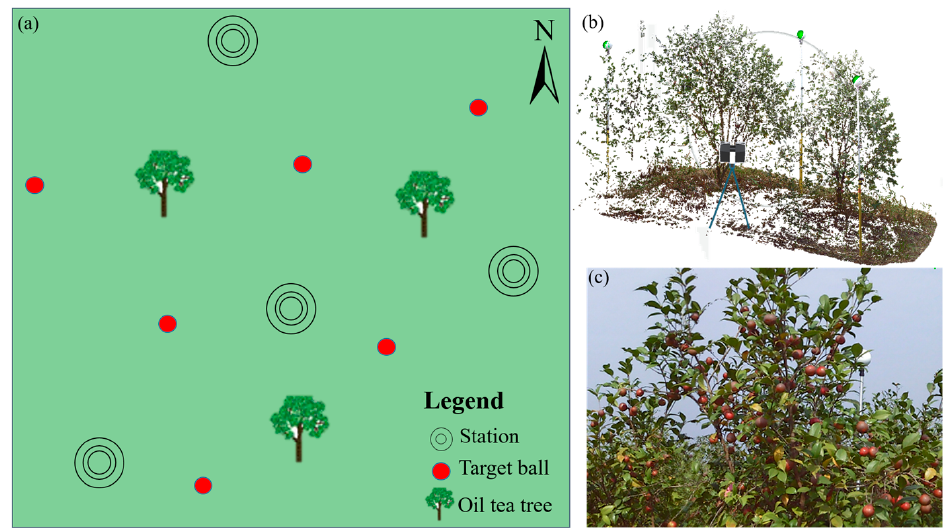
Figure 3. Schematic diagram of the oil tea tree and fruits’ point cloud acquisition. ( a ) Scanning stations for point cloud acquisition, ( b ) point cloud data of the oil tea tree and fruits, and ( c ) photograph of the oil tea tree and fruits.